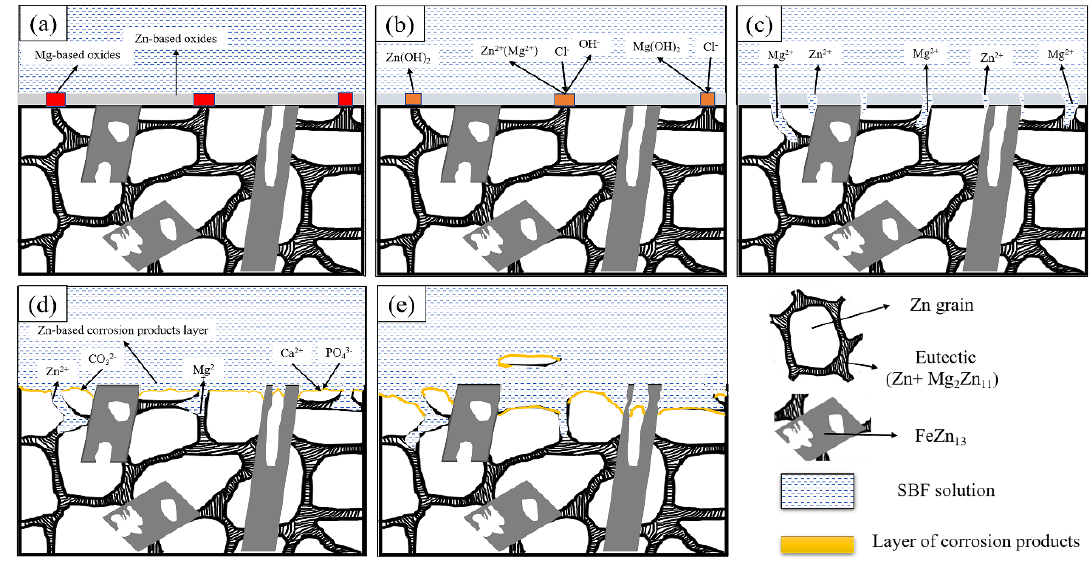
Figure 9. Schematic diagram of in vitro biocorrosion of the Zn1FexMg alloy in simulated body fluids: ( a – e ) are the sequence from the beginning of corrosion to the detachment of a small part of the Zn Matrix.